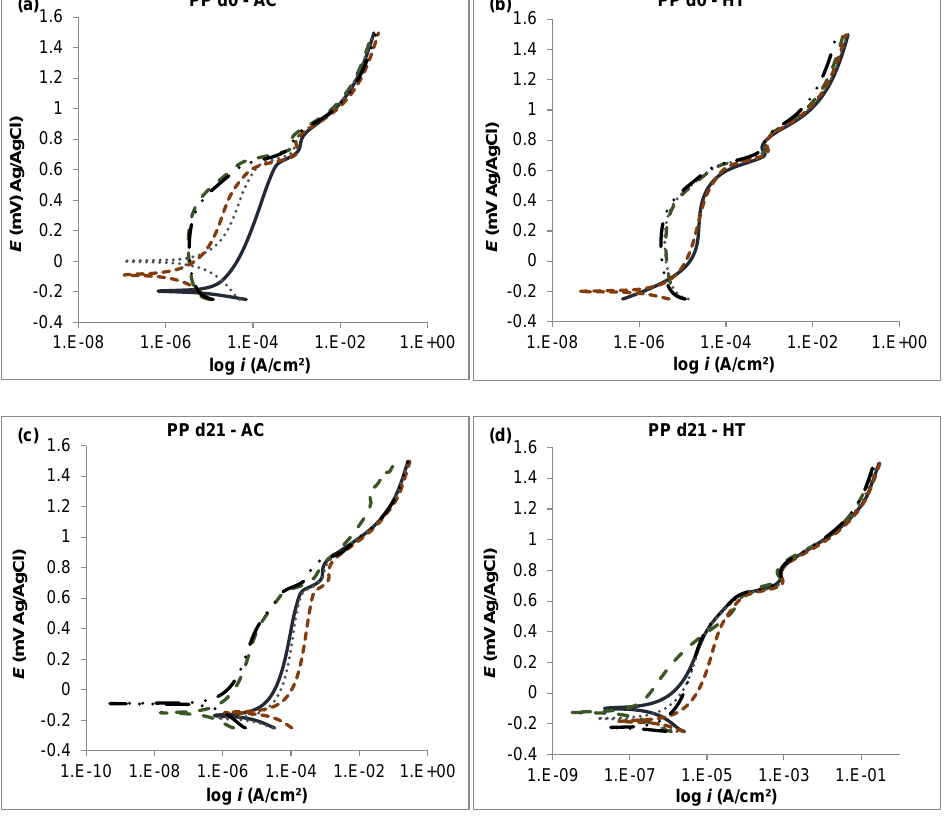
Figure 7. Potentiodynamic polarization curves. ( a ) As-cast and ( b ) heat-treated alloys at Day 0 of immersion, and (c) as-cast and (d) heat-treated alloys at Day 21 of immersion; (—) 0B, (– –) 0.06B, ( ···· ) 0.25B, (- - - -) 0.5B, and (– · · ) 1B.